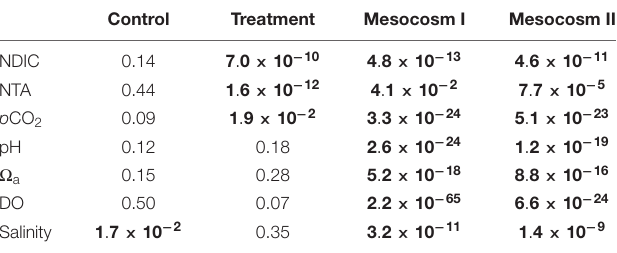
TABLE 2 | Student’s t -test results ( p -value) comparing the difference in salinity normalized DIC (NDIC) and TA (NTA), p CO 2 , pH, (cid:127) a , DO and salinity between the replicate mesocosms during the control and treatment periods, and the difference between the control and treatment periods in the replicate